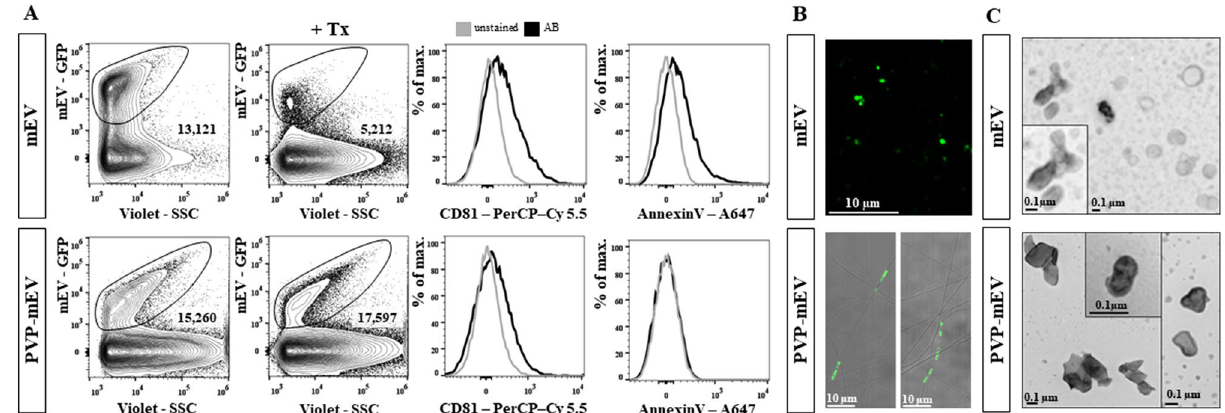
Figure 3. Comparison of free mEVs and mEV-loaded PVP fibers (PVP-mEVs). Free mEVs and PVP-mEVs were compared by flow cytometry based on GFP signal, TritonX-100 lysis, CD81 and phosphatidylserine (AnnexinV) markers ( A ). The mEVs were detected based on GFP fluorescence, while nanofibers were detected with visible light using a confocal laser scanning microscope ( B ). The presence and morphology of mEVs were confirmed by transmission electron microscopy (TEM) ( C ). (AB: antigen specific staining with antibody, Tx: Triton